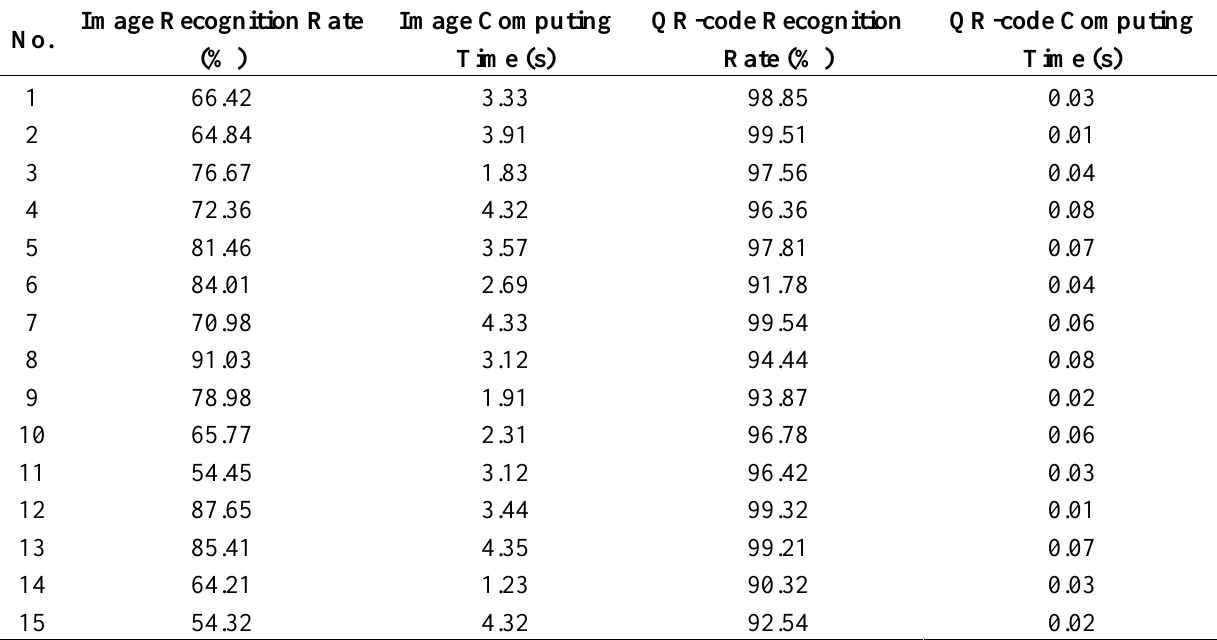
Table 2. The results of QR-code and image